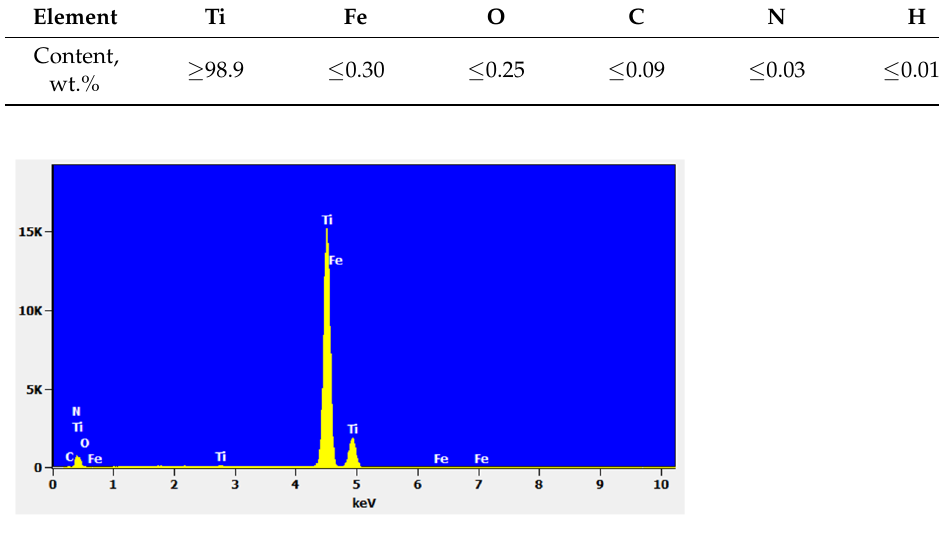
( d ) Figure 4. Numerical model of forming handle part (with mesh of finite elements): ( a ) initial forming; ( b ) supplementary forming; ( c ) flange trimming; ( d ) final forming.